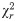
Tuning the protein-water interaction strength of the Martini force field.We varied the protein-water interaction strength by a factor λ, and calculated χr2 for each dataset (A-D). Vertical grey lines are the values of λ giving the best fit to the given dataset. No vertical line is given for SANS at 42% D2O as the variation is χr2 is very small. (E) Average Rg as calculated directly from the simulation. The horizontal red line is the value of Rg determined from the SAXS data.